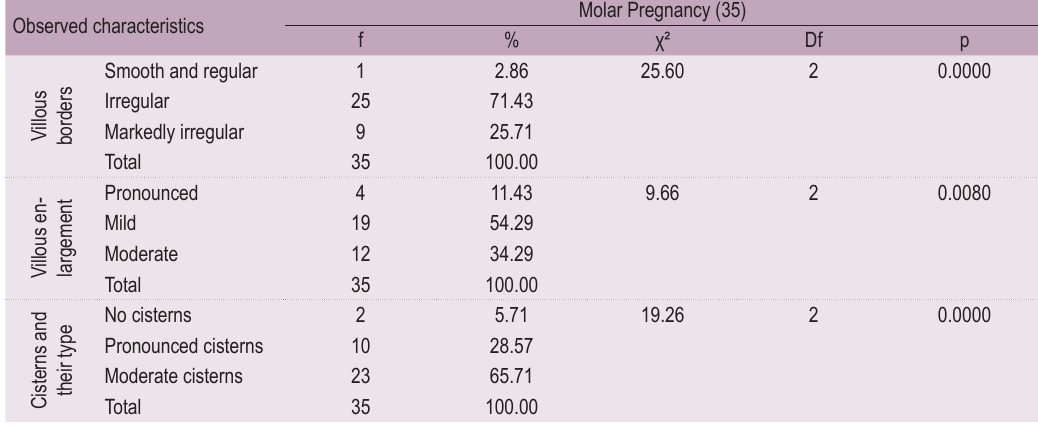
X 2 = 0,641; v=3; p=0.887 TABLE 8. Number and characteristics of patients according to pathomorphological